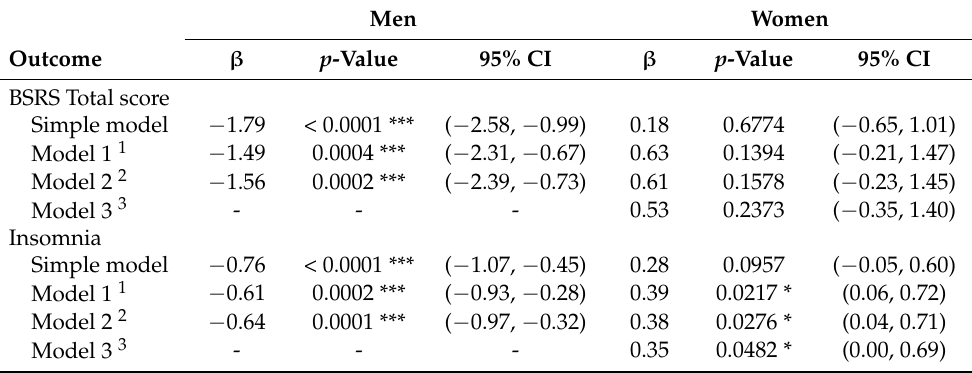
Table 4. Simple and multiple linear regression analysis of BSRS-5 outcome measures versus predictor variables (serum magnesium) by